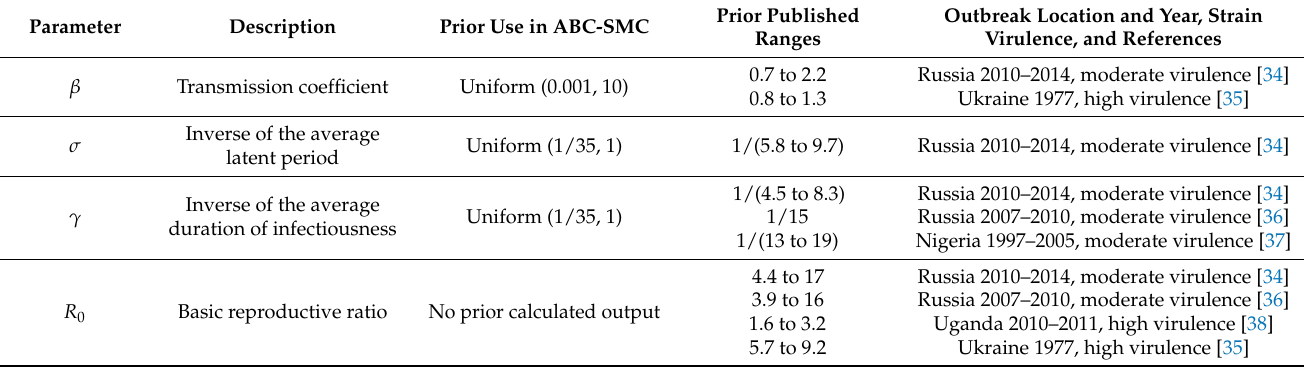
Table 1. Description of model parameters and prior distributions used in the ABC-SMC, based on published information from empirical observations of within-farm spread of African swine